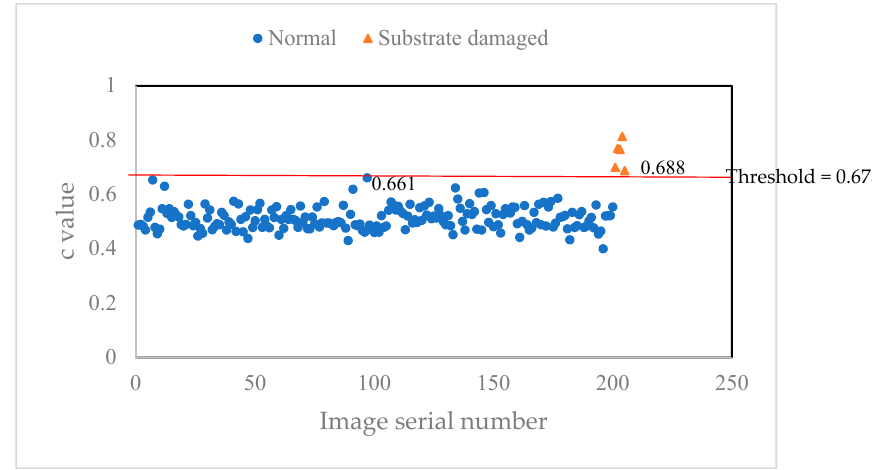
Figure 15. Feature scatter plot of the c value of the substrate lower part.